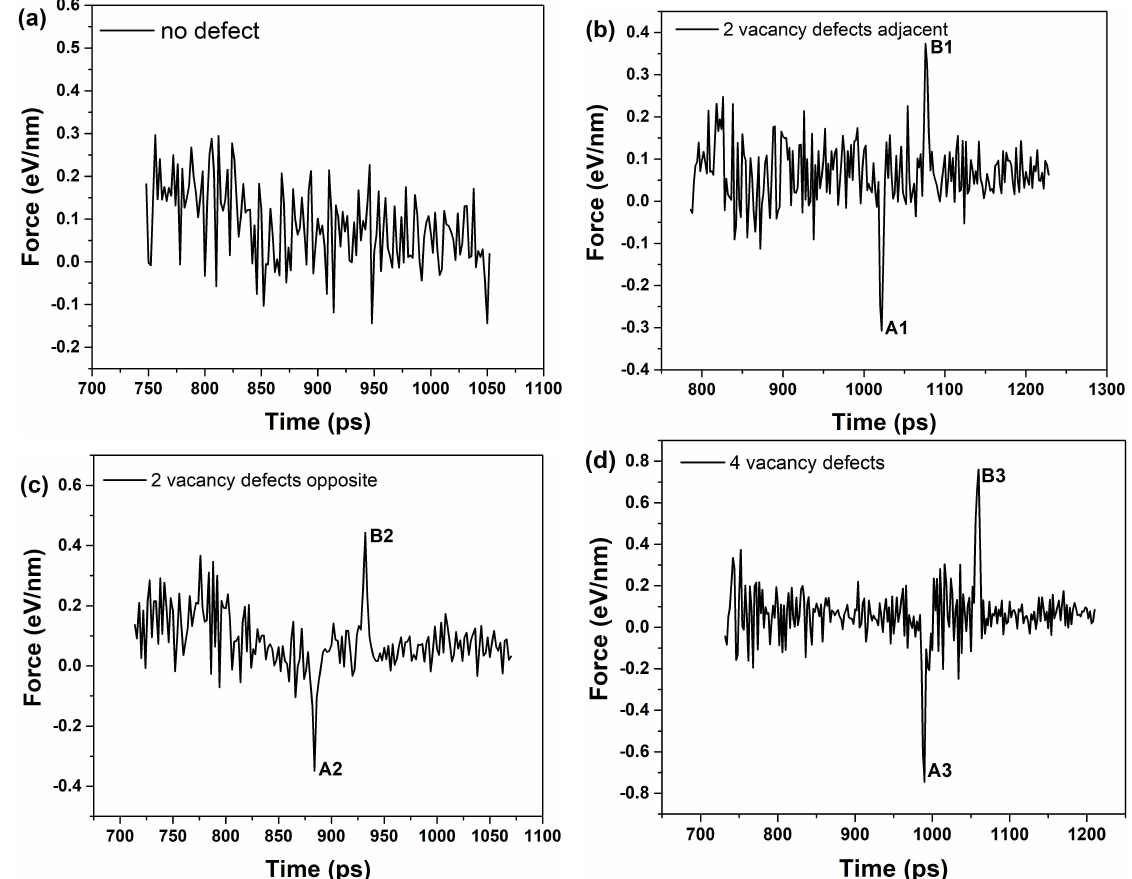
Figure 6: Comparison of the external force acting on the outer tube during the first period of movement for the double-walled system containing no defect, 2 vacancy defects adjacent, 2 vacancy defects opposite,4 vacancy defects in the inner nanotube. The direction of the external force points to the positive direction of the coordinate